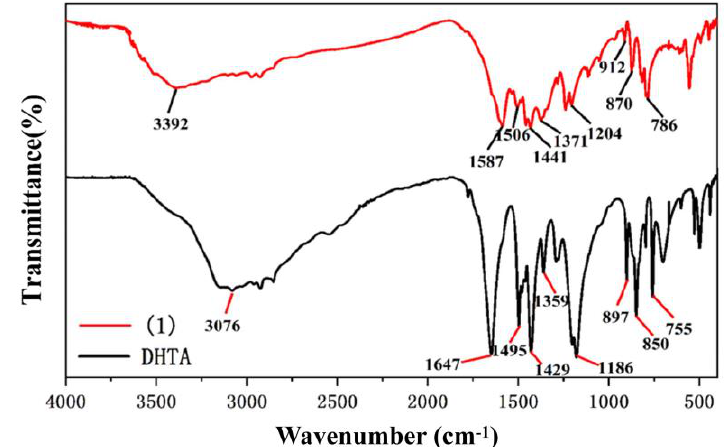
Figure 5. IR spectra of 1 and DHTA.